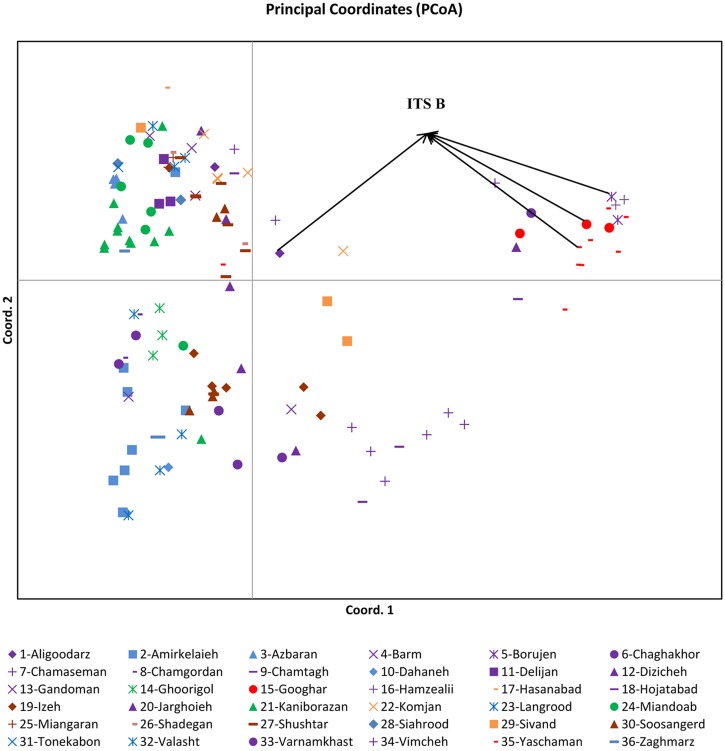
PCoA grouping of 133 individuals from 36 sites.The samples from Aligoodarz (1), Borujen (5), Googhar (15), and Yaschaman (36), Hamzeali (16) are grouped separately (ITS B). (symbols of sites situated along the same mountain range share a same color).